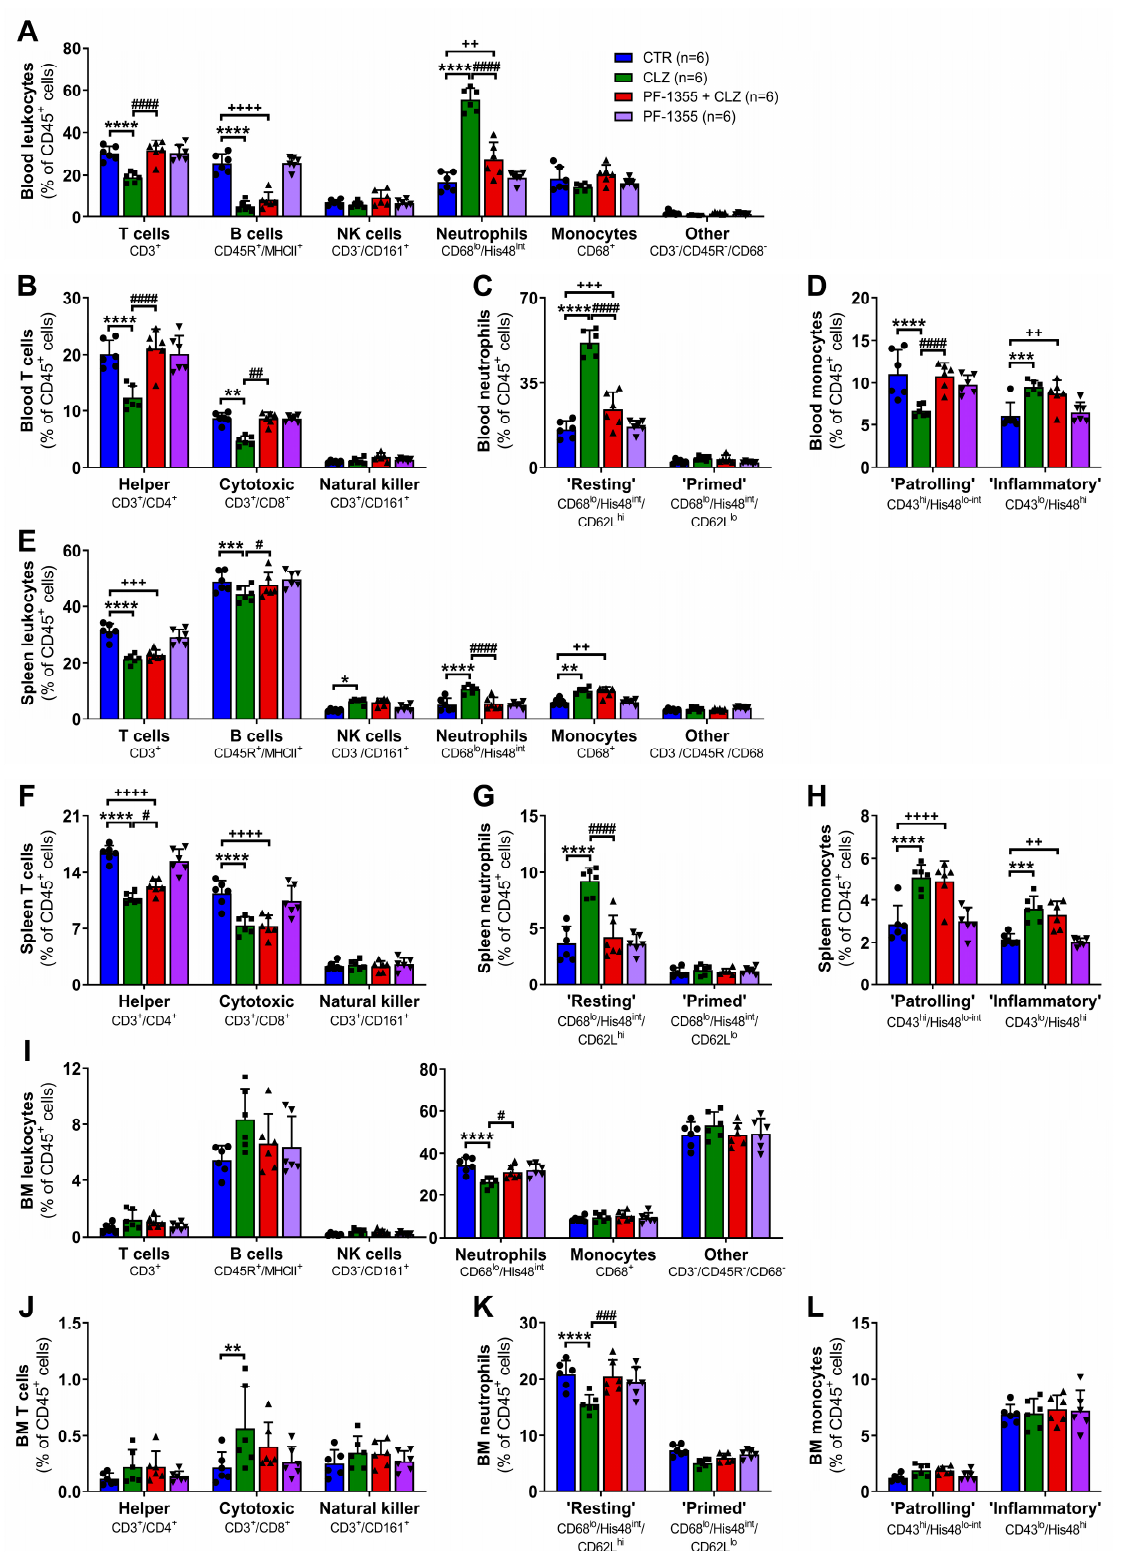
Figure 6. PF-1355 pretreatment attenuates clozapine-induced changes in neutrophil mobilization and other immune subsets in rats. Flow cytometric phenotyping of basic immune cell populations ( A , E , I ), and T lymphocyte ( B , F , J ), neutrophil ( C , G , K ), and monocyte ( D , H , L ) subsets in the blood ( A – D ), spleen ( E – H ), and bone marrow ( I – L ) presented as percentage of live, CD45 + leukocytes in female Sprague Dawley